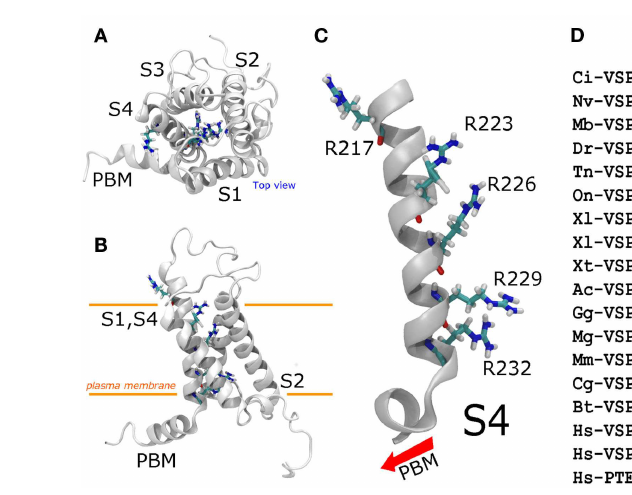
NKRRY, was used as a reference point.The arginine corresponding to Ci-VSP’s R223 and R229 are the most conserved arginine among theVSP consulted for this review.Those sequences labeled with an asterisk are predicted proteins.The two letter code before “VSP” represent the species. Mb, Monosiga brevicollis (marine choanoflagellate); Ci, Ciona intestinalis (sea squirt); Nv, Nemastotella vectensis (sea squirt); Dr, Danio rerio (zebrafish);Tn, Tetraodon nigroviridis (puffer fish); On, Oreochromis niloticus (tilapia); Xl, Xenopus laevis (african clawed frog); Xt, Xenopus tropicalis (frog); Ac, Anolis carolinensis (lizard; green anole); Gg, Gallus gallus (chicken); Mg, Meleagris gallopavo (turkey); Mm, Mus musculus (mouse); Cg, Cricetulus griseus (chinese hamster); Bt, Bos taurus (cow); Hs, Homo sapiens .To make the nomenclature uniform, the following changes in notation were